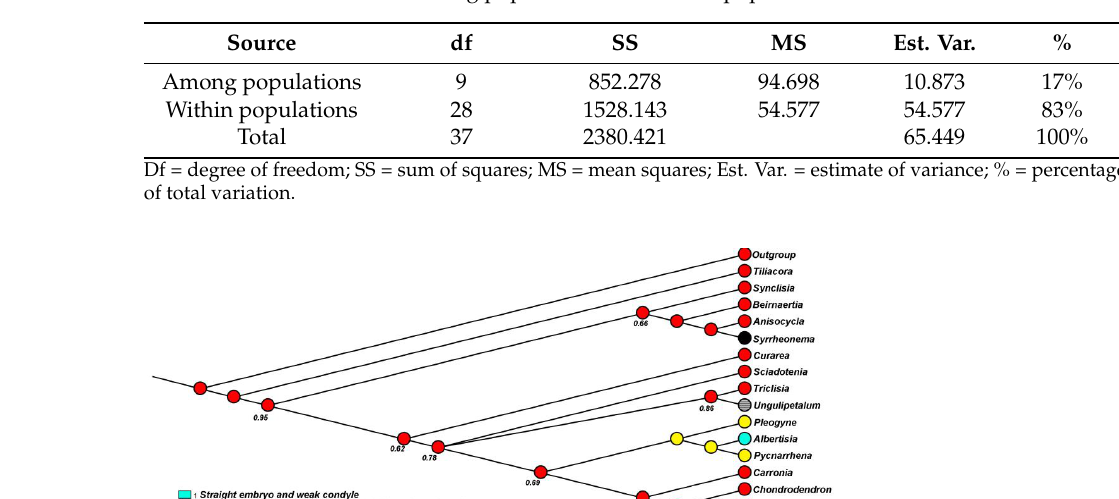
Figure A2. Maximum likelihood and Bayesian phylogenetic tree of the tribe Tiliacoreae based on the combination of rbcL , atpB , matK , ndhF , trnL-F , trnH-psbA , rps16 , 26S rDNA, and ITS regions. * indicates BS = 100% or PP = 1.0; ^ indicates incongruency between ML and Bayesian phylogenetic trees.